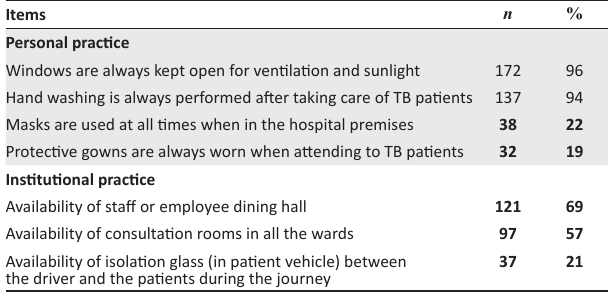
TABLE 3: Practices of participants – correct responses ( n = 181). TABLE 2: Knowledge of tuberculosis ( n = 181).